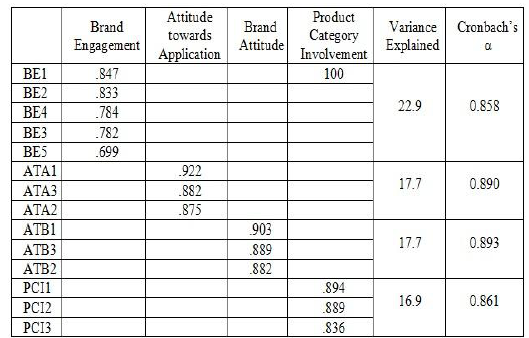
Table 2: Factor Loadings of the